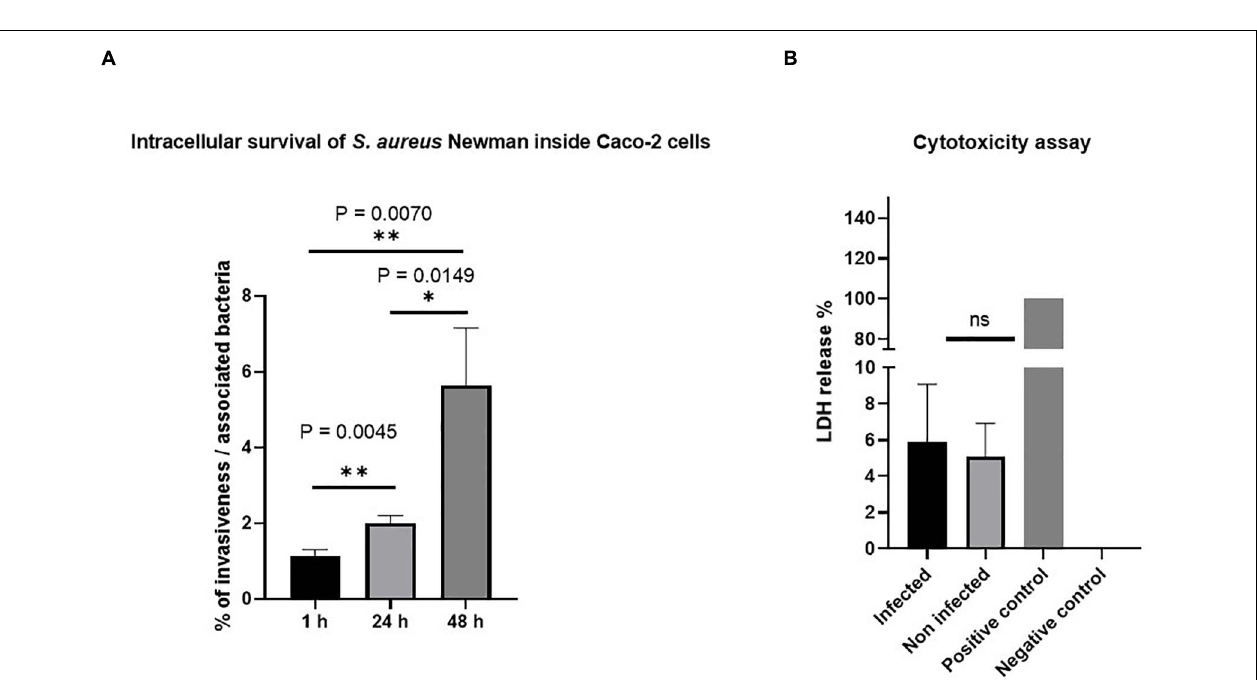
FIGURE 2 | Invasion of Staphylococcus aureus Newman in Caco-2 cells. (A) S. aureus Newman-infected Caco-2 cells survived and multiplied inside the cells without affecting cell viability. The percentage of invasive bacteria showed significant differences between the three different time points after 1, 24, and 48 h of gentamicin treatment. The data were obtained from colony-forming unit (CFU) count of cell lysate infected with a multiplicity of infection (MOI) of 10. (B) The viability of Caco-2 cells was not affected upon S. aureus infection as estimated by lactate dehydrogenase (LDH) assay. Forty-eight hours post-infection, LDH release was measured